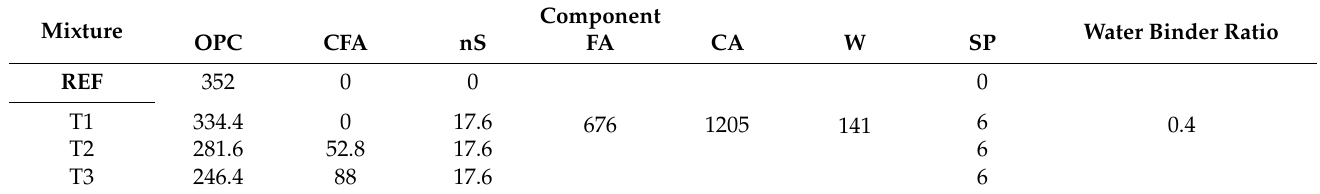
Table 4. Mixture proportions of concretes (kg/m 3 ).